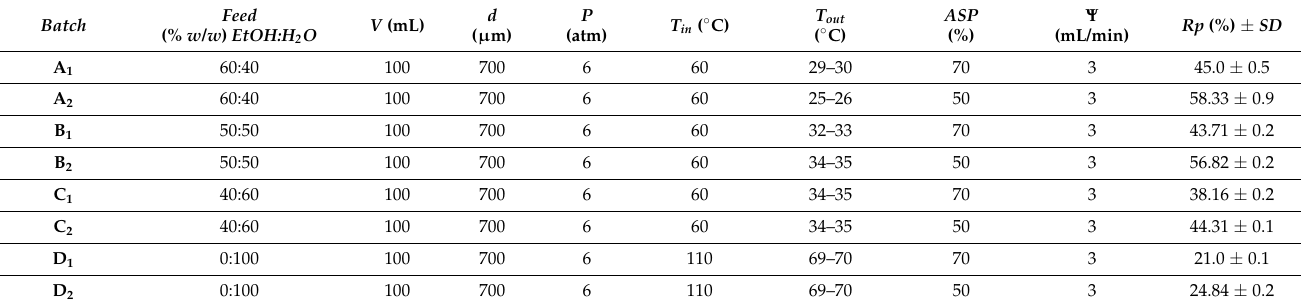
Table 1. Variables and yield of the spray-drying process. d ( µ m): nozzle diameter; T in : inlet temperature; T out : outlet temperature; p: air pressure; ASP: aspiration; Ψ : flow rate; Rp: process yield; V: sprayed volume; SD: standard